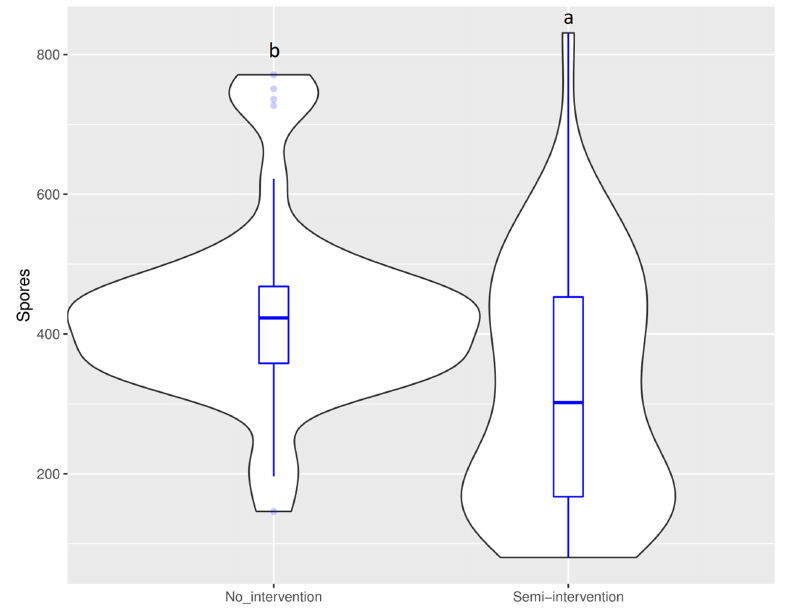
Figure A1. Spore density present in cocoa roots from the two cropping systems (semi-intervention and no-intervention). Different letters indicate significant differences at p < 0.05 after the nonparametric Mann-Whitney test.